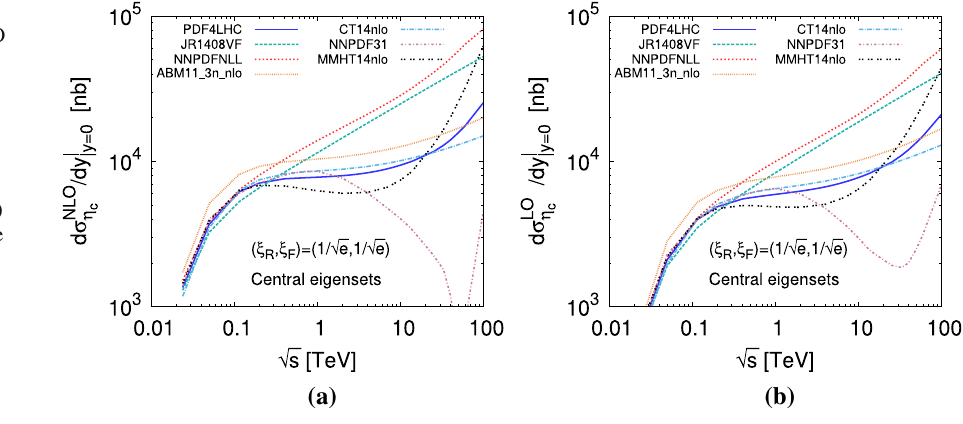
| η η Fig. 7 d σ NLO y = 0 for c (top) and b (bottom) (for PDF4LHC (left), JR14NLO08VF (middle), NNPDFsxNLONLL (right)) as a function of dy for the usual 7-point scale choices and our ˆ μ f scale with μ R = μ F , i.e. (ξ R ,ξ F ) = ( 1 / | η Fig. 8 d σ NLO y = 0 for c a at dy NLO and b LO for various NLO PDF choices